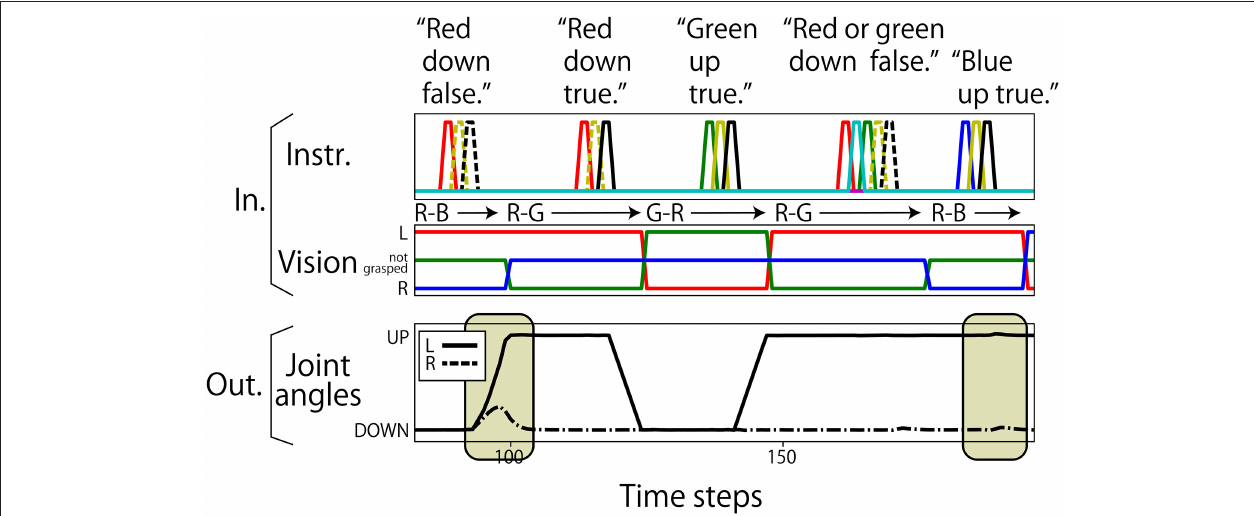
FIGURE 11 | In unexperienced situations of the flag task, some different patterns of failures could be seen (indicated by beige-colored rounded boxes). The first case, indicated by the left rounded box, was that the final posture was correct but the trajectory was not stable, thus it could not satisfy the criterion that the error should be within 0.04. The second pattern was that a wrong action was chosen. In the case indicated by the right rounded box, the right arm had to be raised. However, it was actually kept in the DOWN posture.